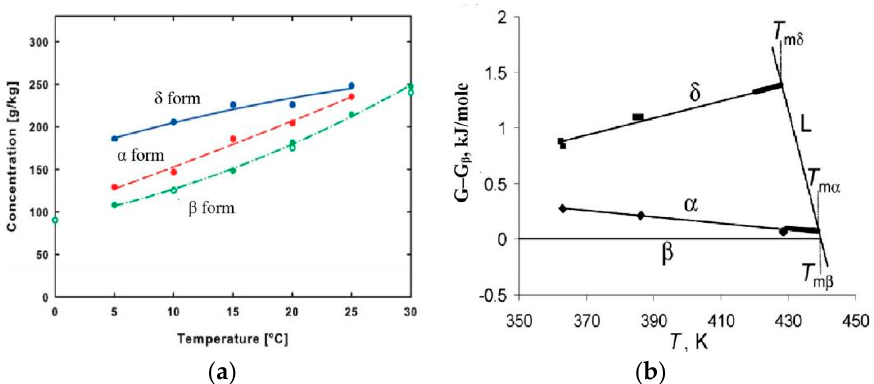
Figure 4. ( a ) Gibbs free energy and solubility. Adapted with permission from Ref. [25]. Copyright 2010, American Chemical Society; ( b ) of different mannitol polymorphs. Adapted with permission from [31]. Copyright 2005, American Chemical Society.